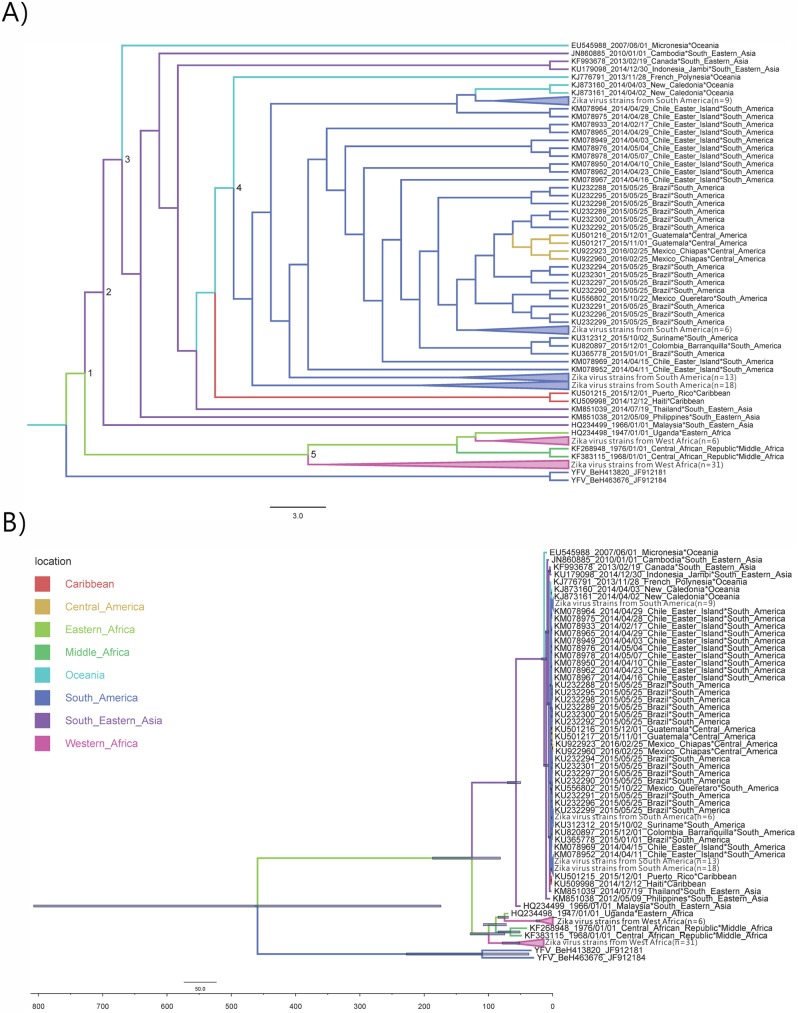
Bayesian phylogeographic tree of NS5.(A) cladogram, (B) phylogram, with the horizontal bar indicating the tMRCA 95% HPD of each node. Branches are colored according to the most probable location of the descendent nodes. Branches with the number of taxa fewer than five are collapsed for clarity. The time scale represents the number before the present time (2016-02-15).